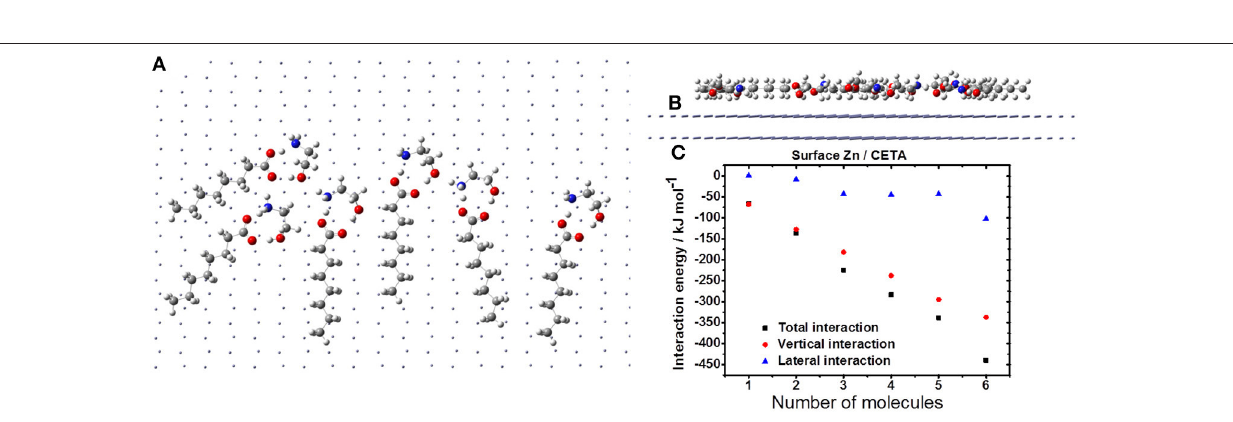
FIGURE 8 | Formation of CETA film on the zinc surface: horizontal (A) and vertical (B) views; (C) interaction energy.